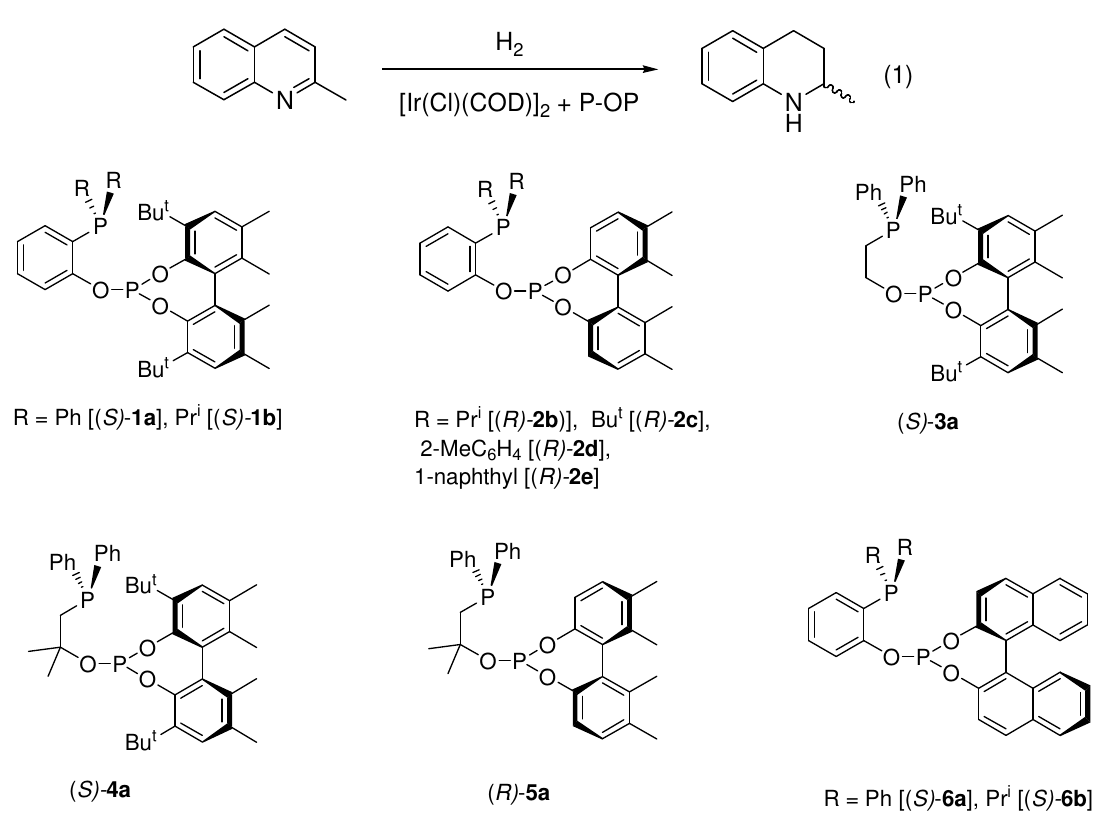
Figure 3. P-OP ligands used in the present